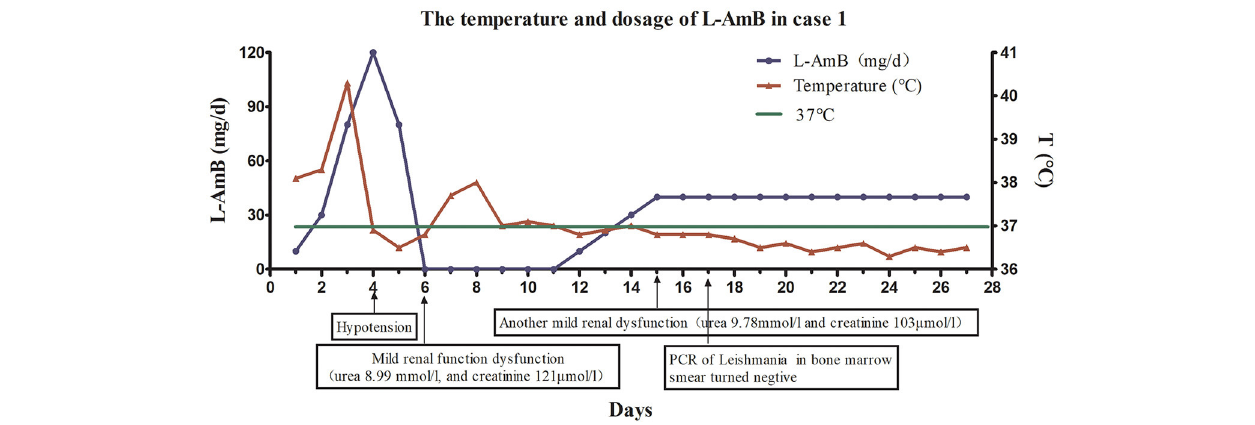
FIGURE 2 | The dose of liposomal amphotericin B (L-AmB) and changes of temperature in Case 1. The initial dosage of L-AmB in the first patient was 10mg/day and the patient’s temperature decreased as the dose of L-AmB was escalated. Dose escalation was performed as follows: 10mg on day 1, 30mg on day 2, 80mg on day 3, and 120mg on day 4. However, the appearance of hypotension on day 4 of the treatment protocol forced the dose reduction on day 5 (80 mg/d). There was mild renal impairment on day 6. Therefore, treatment was interrupted on days 6–11, and his renal function gradually recovered during treatment cessation. Treatment was restarted at a dose of 10mg/kg from day 12, and the dose was gradually increased at a rate of 10 mg/(kg · day). The dose was increased to 40mg on day 15. Since the patient’s renal function was still slightly abnormal at day 15, the dose of L-AmB was not increased, but maintained at 40mg during the next 12 days (day 16–27). Finally, we stopped the medication until the accumulating dose reached 890mg'(12.6mg/kg) on the day 27. Polymerase chain reaction of Leishmania in a bone marrow smear was negative on day